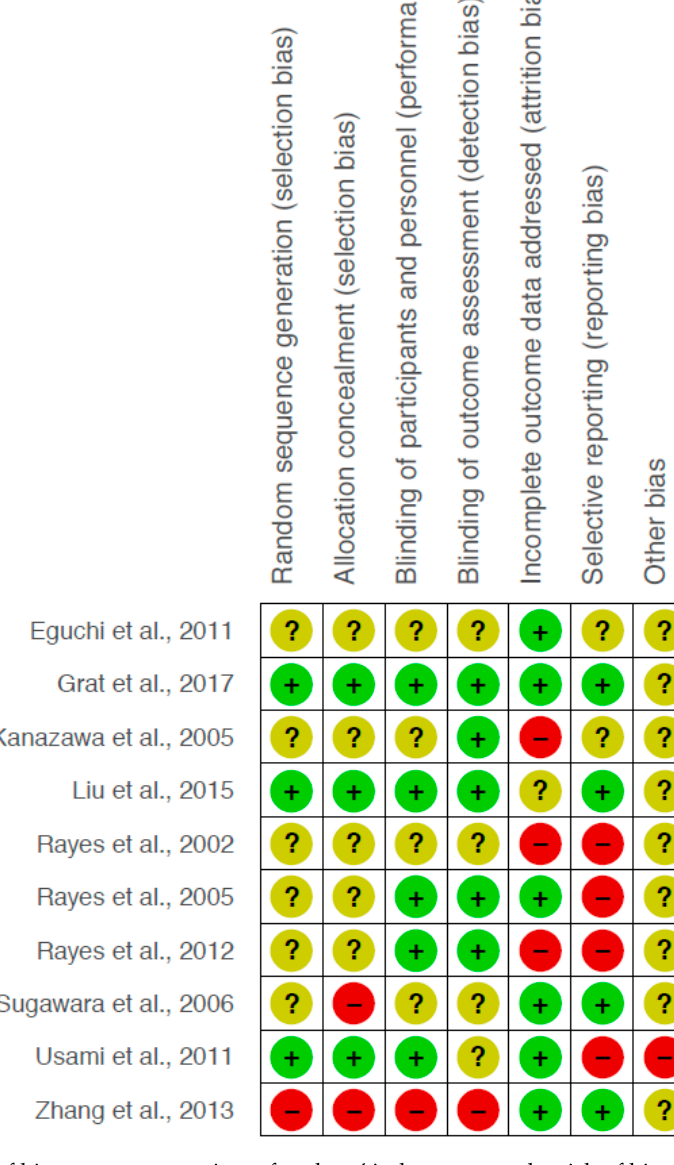
Figure 2. Risk of bias summary: review of authors’ judgement on the risk of bias for the analyzed randomized controlled trials. Red circle symbolizes high risk of bias, green circle symbolizes low risk of bias, yellow circle symbolizes unclear risk of bias.